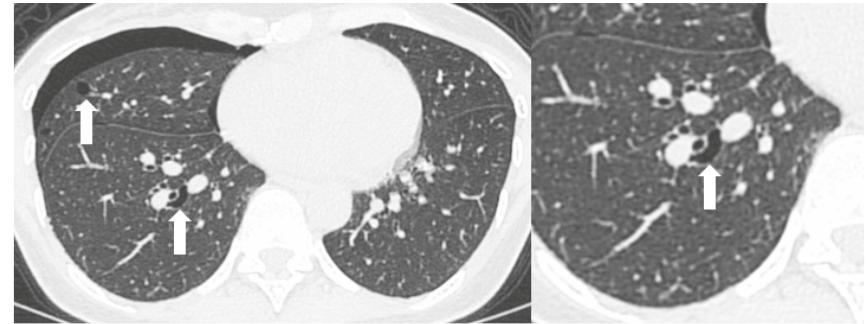
Figure 3: Pulmonary computed tomography demonstrating a right pneumothorax and multiple cysts (arrow). An ellipsoidal cyst abuts on the proximal portion of the pulmonary